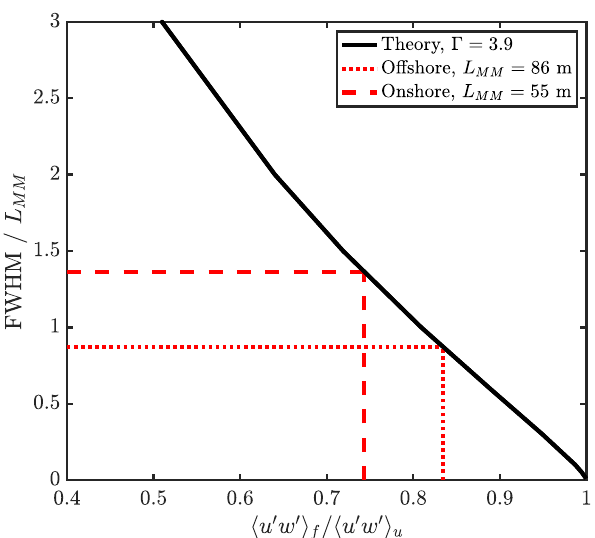
Figure 6. Ratio of the filtered to unfiltered momentum flux as a function of the ratio of the lidar’s probe length to the turbulence length scale ( L MM ). The dotted lines represent estimated values for onshore and offshore sites at 100